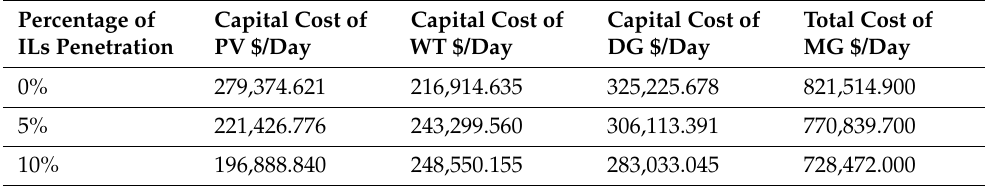
Table 9. Capital cost involved in various sources for the percentage of ILs penetration.